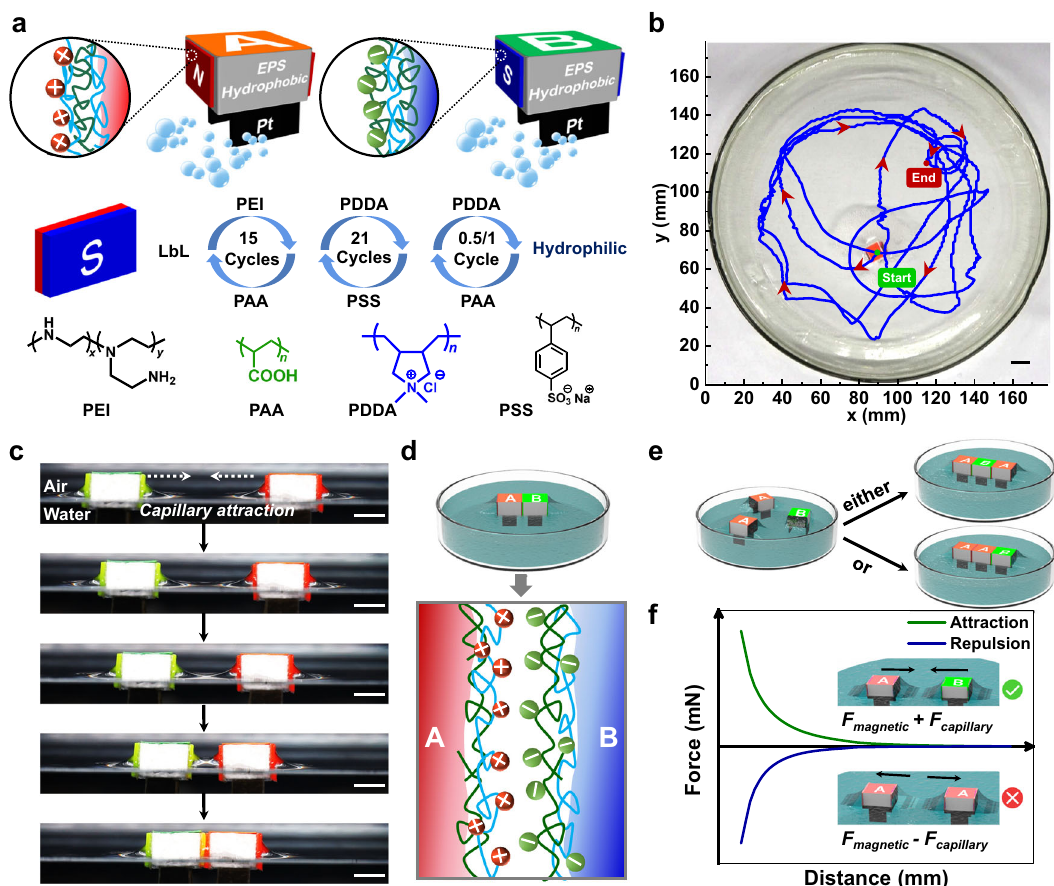
Fig. 1 | Design of MSA building blocks and the challenge of self-sorting in macroscopic self-assembly. a Schematic illustration of expanded polystyrene (EPS) building blocks with self-propulsive systems (catalyst of platinum, Pt), ani- sotropicwettabilityandmagneticplates. b Motiontrajectoryofonebuildingblock on the surface of H 2 O 2 solution. Scale bar: 1cm. c Snapshot photographs of A-B assembly driven by the capillary attraction at an air/water interface. Scale bars: